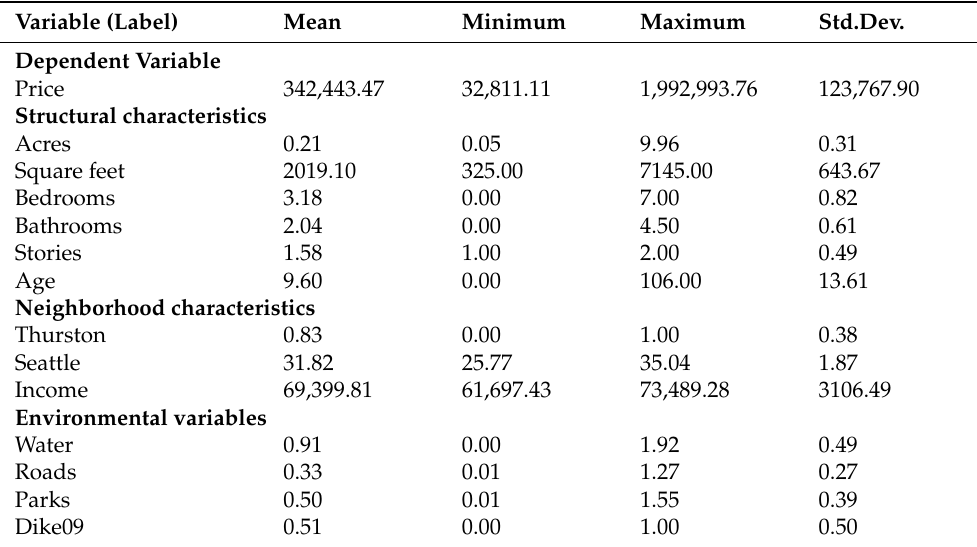
Table 2. Summary statistics for hedonic pricing model